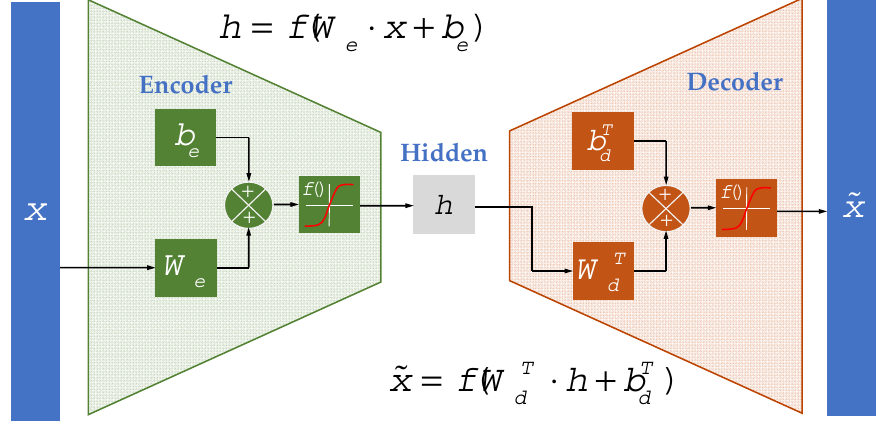
Figure 8. Basic autoencoder structure.